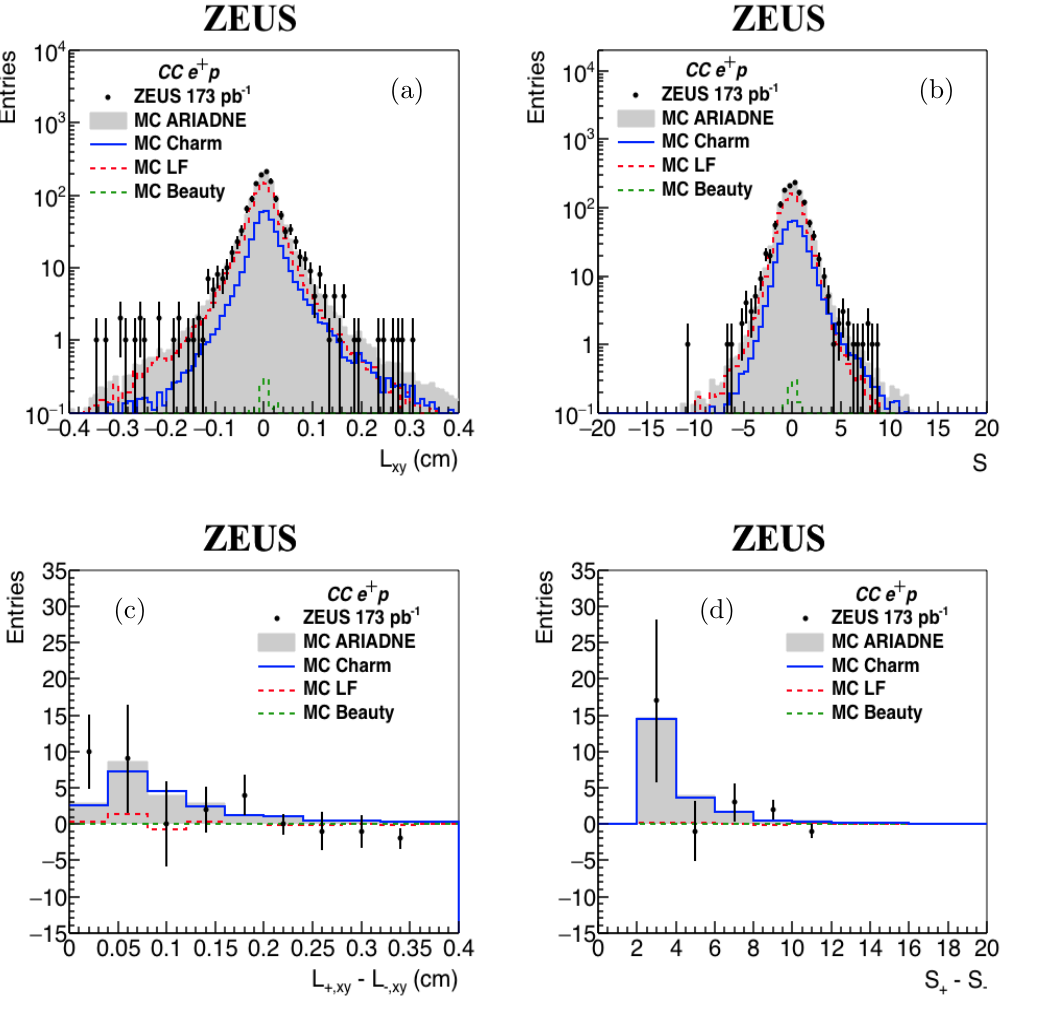
Figure 7. Comparison between data (points with vertical error bars) and MC (histogram) for e + p collisions for distributions of (a) the 2D decay length L xy and (b) signi(cid:12)cance S distribution and for distributions of the subtracted (c) decay-length L + xy (cid:0) L (cid:0) xy and (d) signi(cid:12)cance S + (cid:0) S (cid:0) distribution. The labels are the same as in (cid:12)gures 3 and 4. \MC beauty" represents events with beauty but no charm